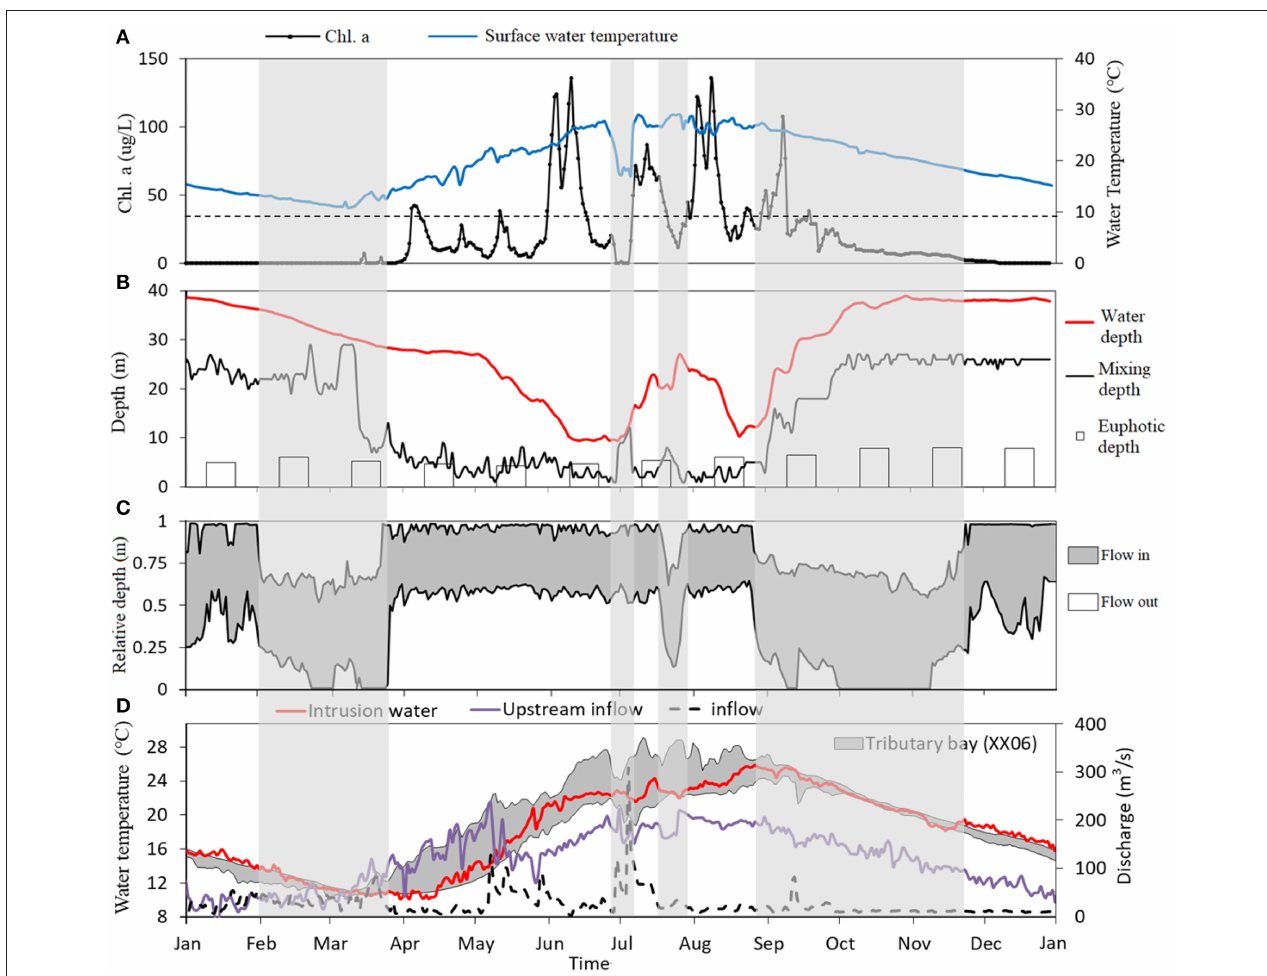
FIGURE 8 | Annual variation of each parameter in 2012. (A) Daily surface Chl.a concentration and water temperature at upper site (S4). The dash line is the threshold of algal bloom (30 µ g/L). (B) Daily water depth, mixing depth, and monthly measured euphotic depth at upper site (S4). (C) Relative depth of intrusion water from mainstream at mouth site (S2). (D) Daily water temperature at mainstream, tributary bay (S3), and inflow and upstream inflow. Gray filled box represents the four special periods differed to the other